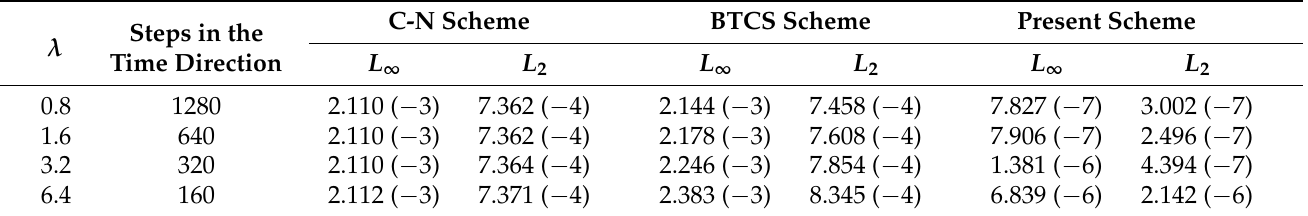
, T = 1 with different mesh ratio λ = τ 32